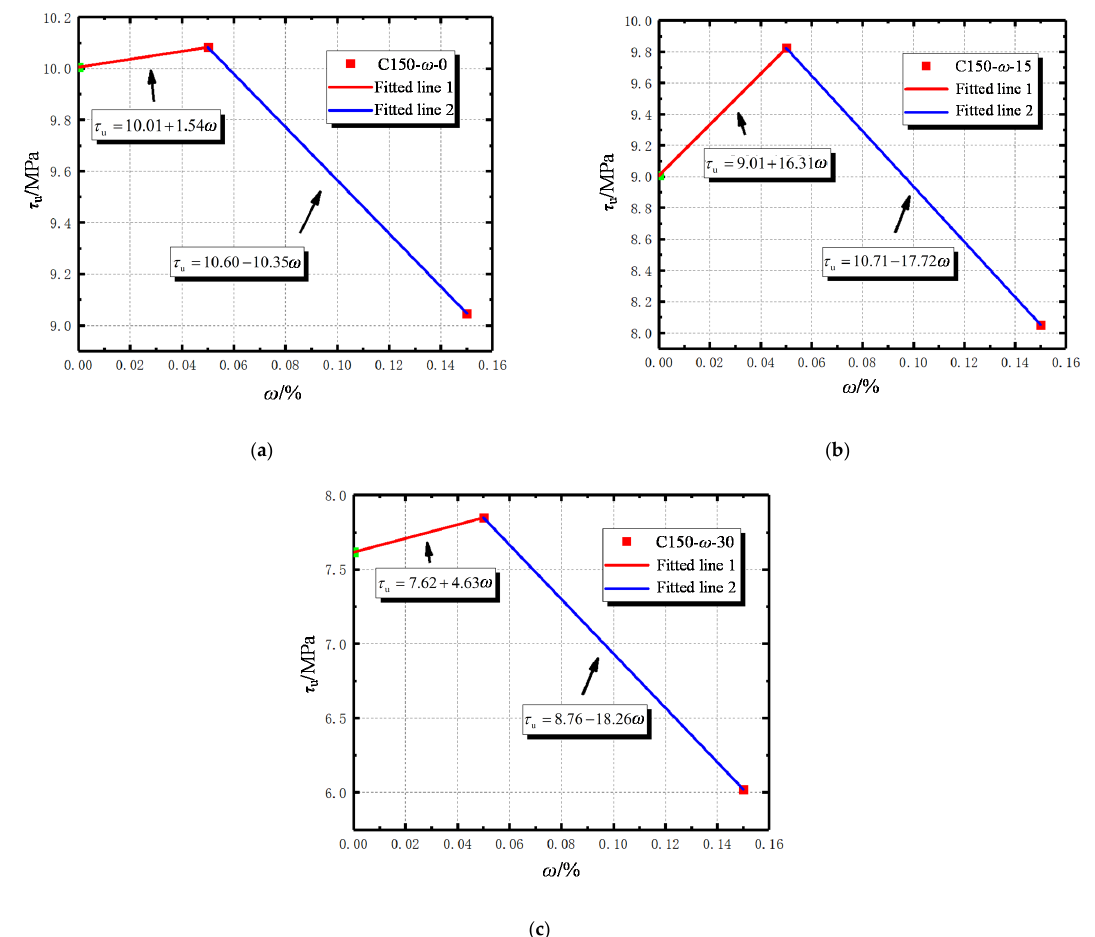
Figure 10. The law of ultimate bond strength changing with rust rate: ( a ) C150- ω -0; ( b ) C150- ω -15; ( c ) C150- ω -30.